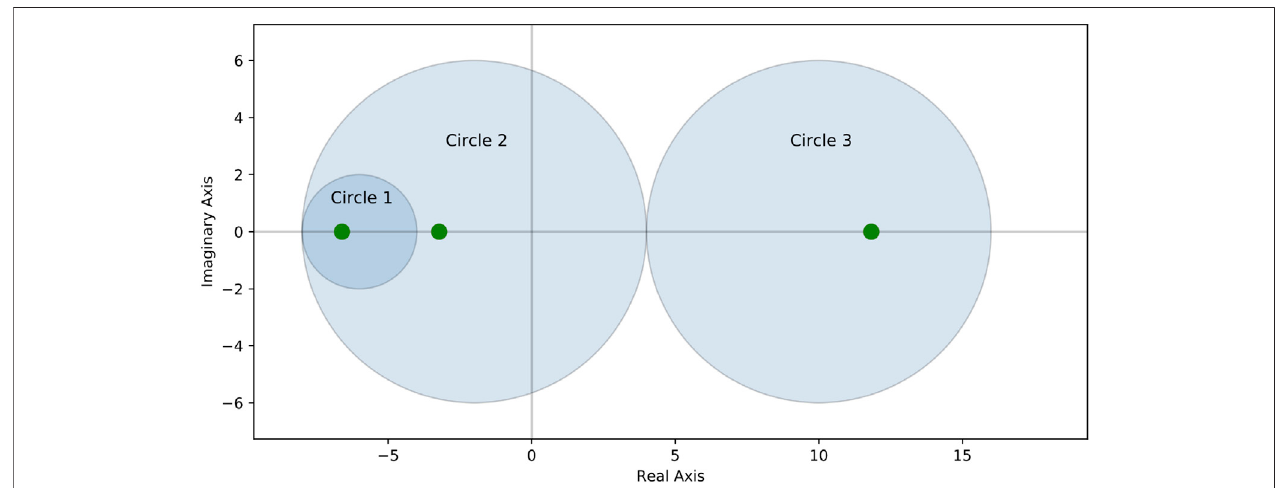
FIGURE 4 | Visualization of Gershgorin ’ s circle theorem on an exemplary